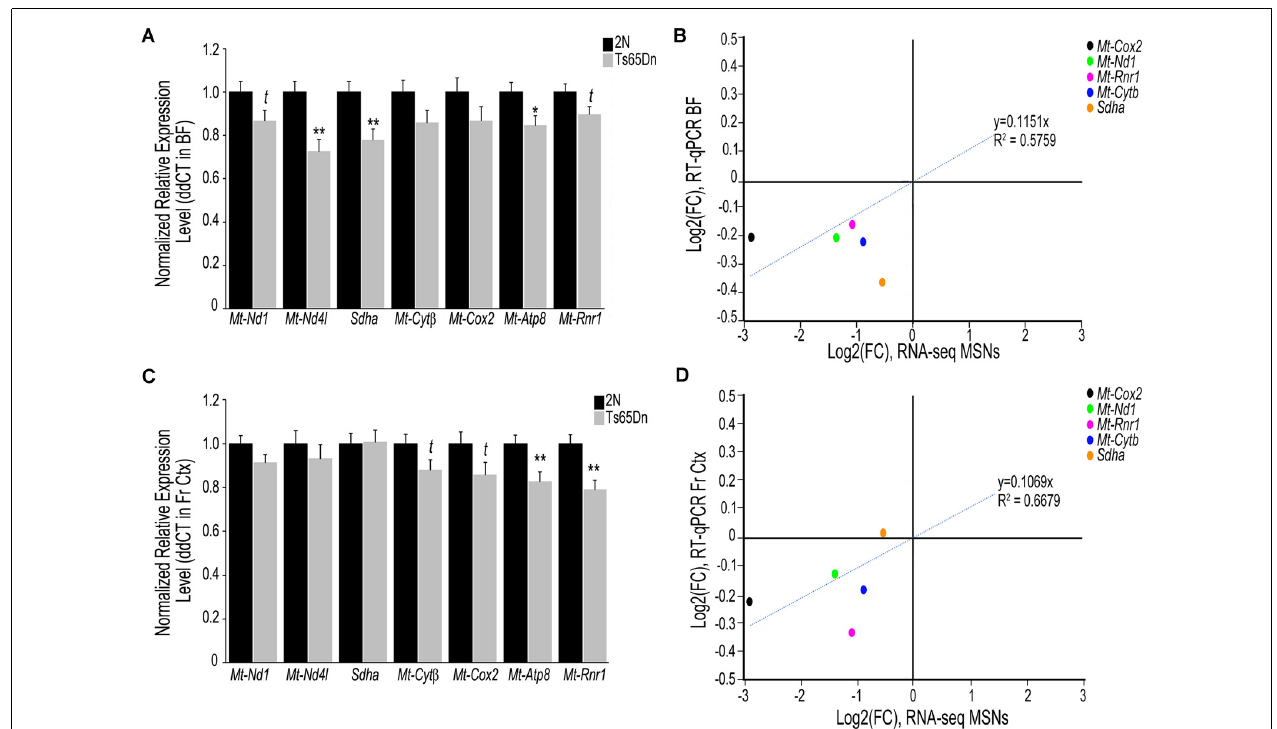
FIGURE 2 | Interrogation of oxidative phosphorylation Complex I-V subunit gene expression within the trisomic basocortical circuit. RT-qPCR was performed to determine gene expression levels using regional dissections of the basal forebrain (BF; A,B ) and Fr Ctx (C,D) from Ts65Dn and 2N littermates at ∼ 6 MO for six genes. (A) Bar graph represents ddCT of each gene normalized to 2N levels in the BF. Significant downregulation was found for Mt-Nd4l, Sdha , and Mt-Atp8 and trend-level downregulation was found for Mt-Nd1 , Mt-Cyt β , and Mt-Rnr1 . (B) Correlation plot association between MSN BFCN RNA-seq LFC (x-axis) and BF RT-qPCR LFC (y-axis). (C) Bar graph represents ddCT of each gene normalized to 2N levels in the Fr Ctx. Significant downregulation was found for Mt-Atp8 and Mt-Rnr1 and trend-level downregulation was found for Mt-Cyt β and Mt-Cox2 . (D) Correlation plot association between MSN BFCN RNA-seq LFC (x-axis) and Fr Ctx RT-qPCR LFC (y-axis). While most genes were not significantly downregulated by RT-qPCR, they trended in the same direction (downregulation). Sdha was the only gene that did not correlate with RNA-seq results. Black bars represent relative 2N expression and gray bars indicate Ts65Dn expression normalized to 2N for each gene (standard error of mean (SEM) is indicated by error bars). Key: * p < 0.05, ** p < 0.01; t ,